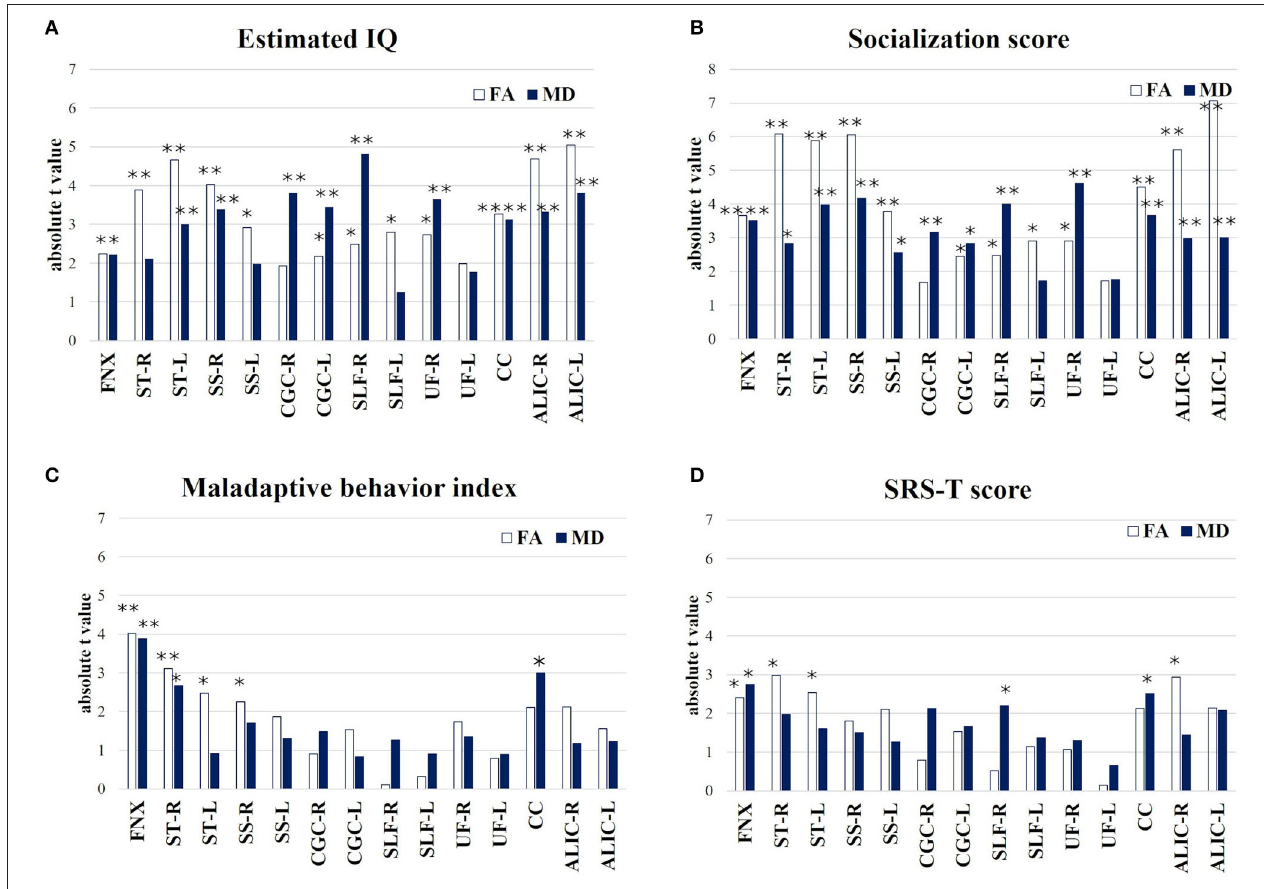
FIGURE 4 | Multiple linear regression (absolute t -value) indicates the strength of association between behavior assessment (A) Estimated IQ; (B) Socialization score; (C) Maladaptive behavior index; (D) SRS-T score and FA/MD in target 7 regions and ALIC. * p < 0.05, ** p < 0.01. FNX, body of the fornix; ST, stria terminalis; SS, sagittal stratum; CGC, cingulum in the cingulate gyrus; SLF, superior longitudinal fasciculus; UF, uncinate fasciculus; CC, splenium of the corpus callosum; ALIC, anterior limb of internal